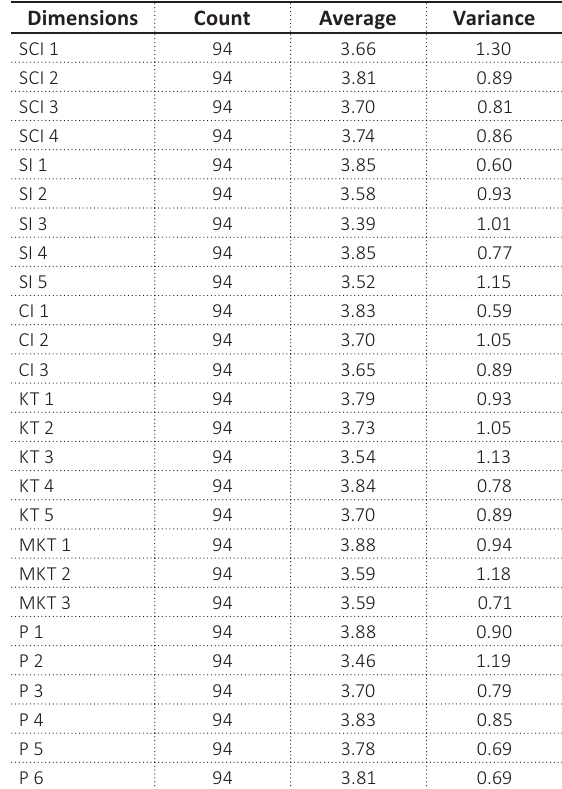
Table 4. Statistics for dimensions of integration management and performance